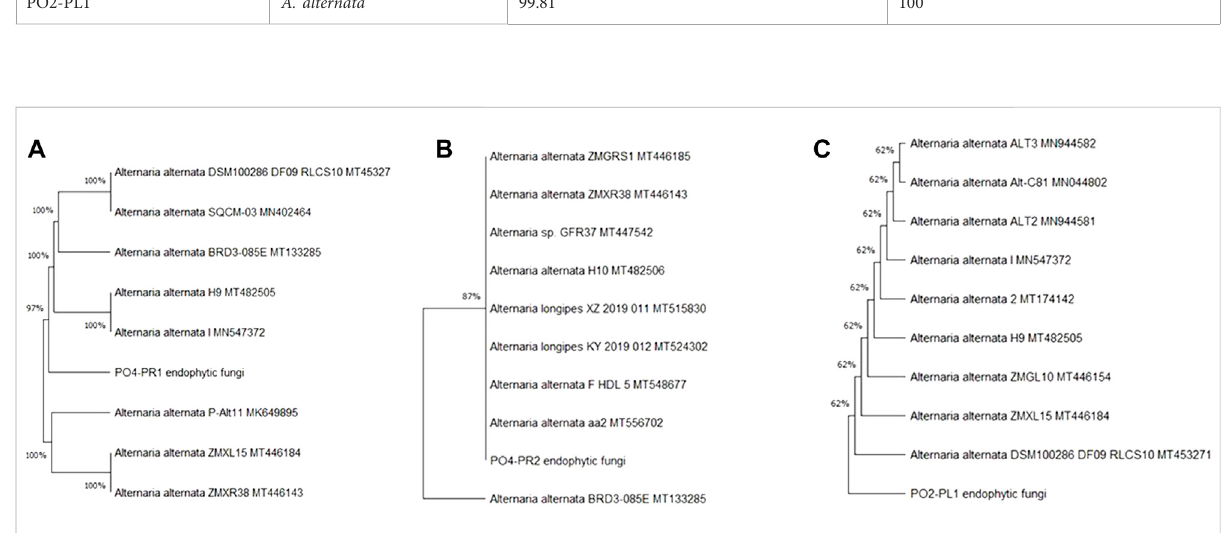
FIGURE 1 Phylogenetic tree of isolated endophytic fungi from S. birrea , and Hypoxis species, (A) PO4-PR1. (B) PO4PR2 (C) PO2PL1. Taxonomic classi fi cation was represented by the maximum-likelihood tree relationships of aidophytic fungal isolates to other sequences from NCB]. Bootstrap values for (1,000 replications) are displayed on the branches of the